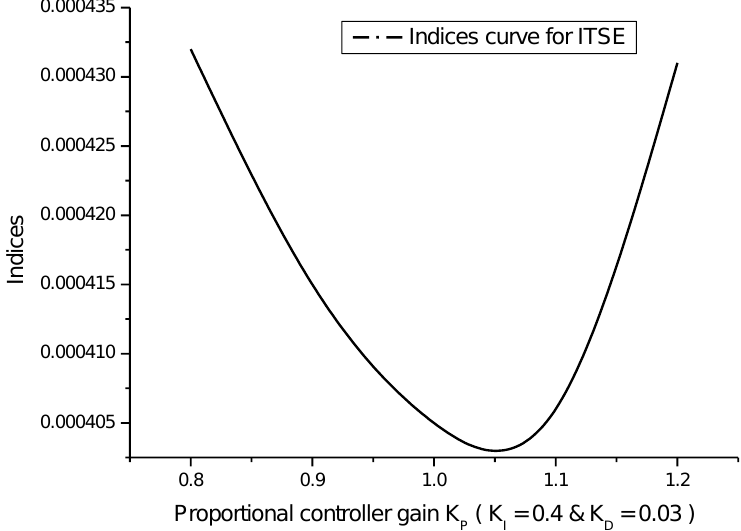
Figure 5. ITSE performance indices curve.